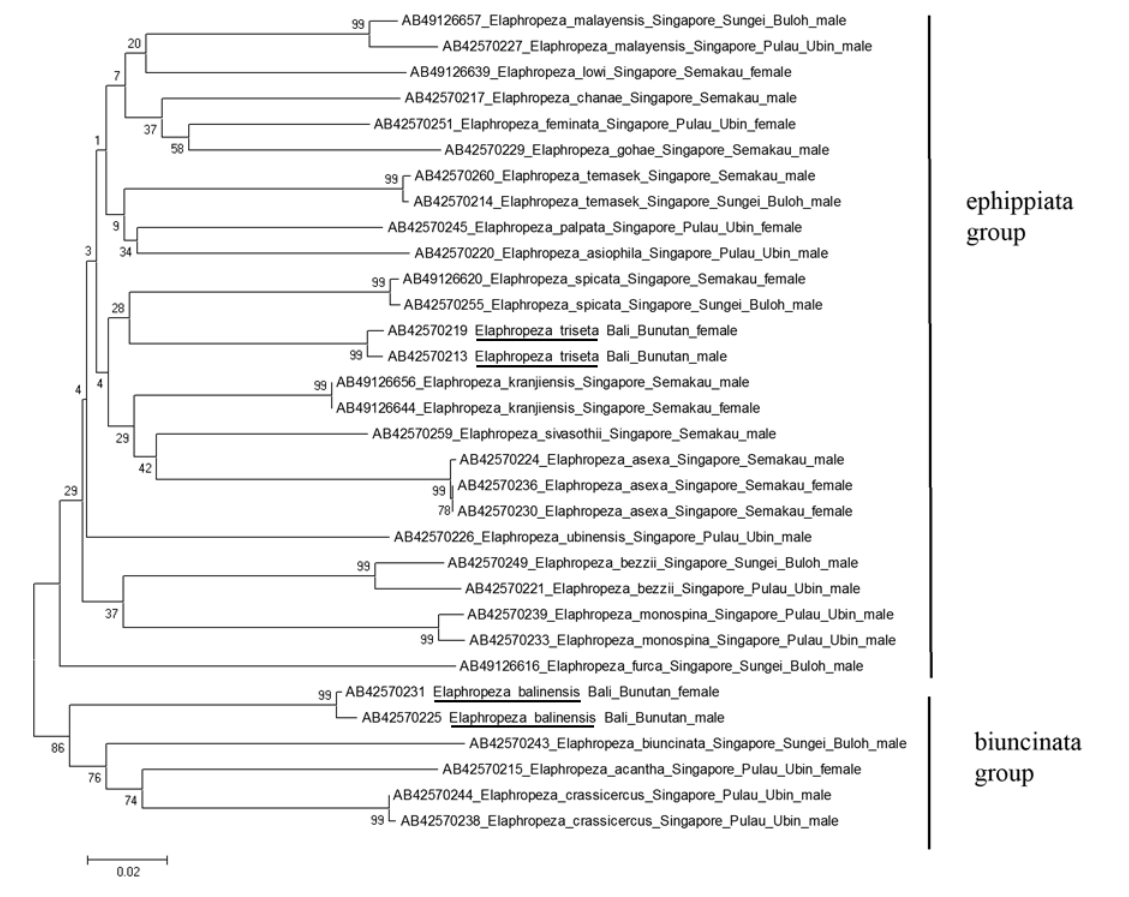
Fig. 11. Neighbour-Joining tree of the COI barcodes of a number of selected Southeast Asian Elaphro- peza species showing the position of E. triseta sp. nov. and E. balinensis sp. nov. (both underlined) in the ephippiata -group and biuncinata -group, respectively. The bootstrap value is indicated at the nodes. The scale of the genetic distance is